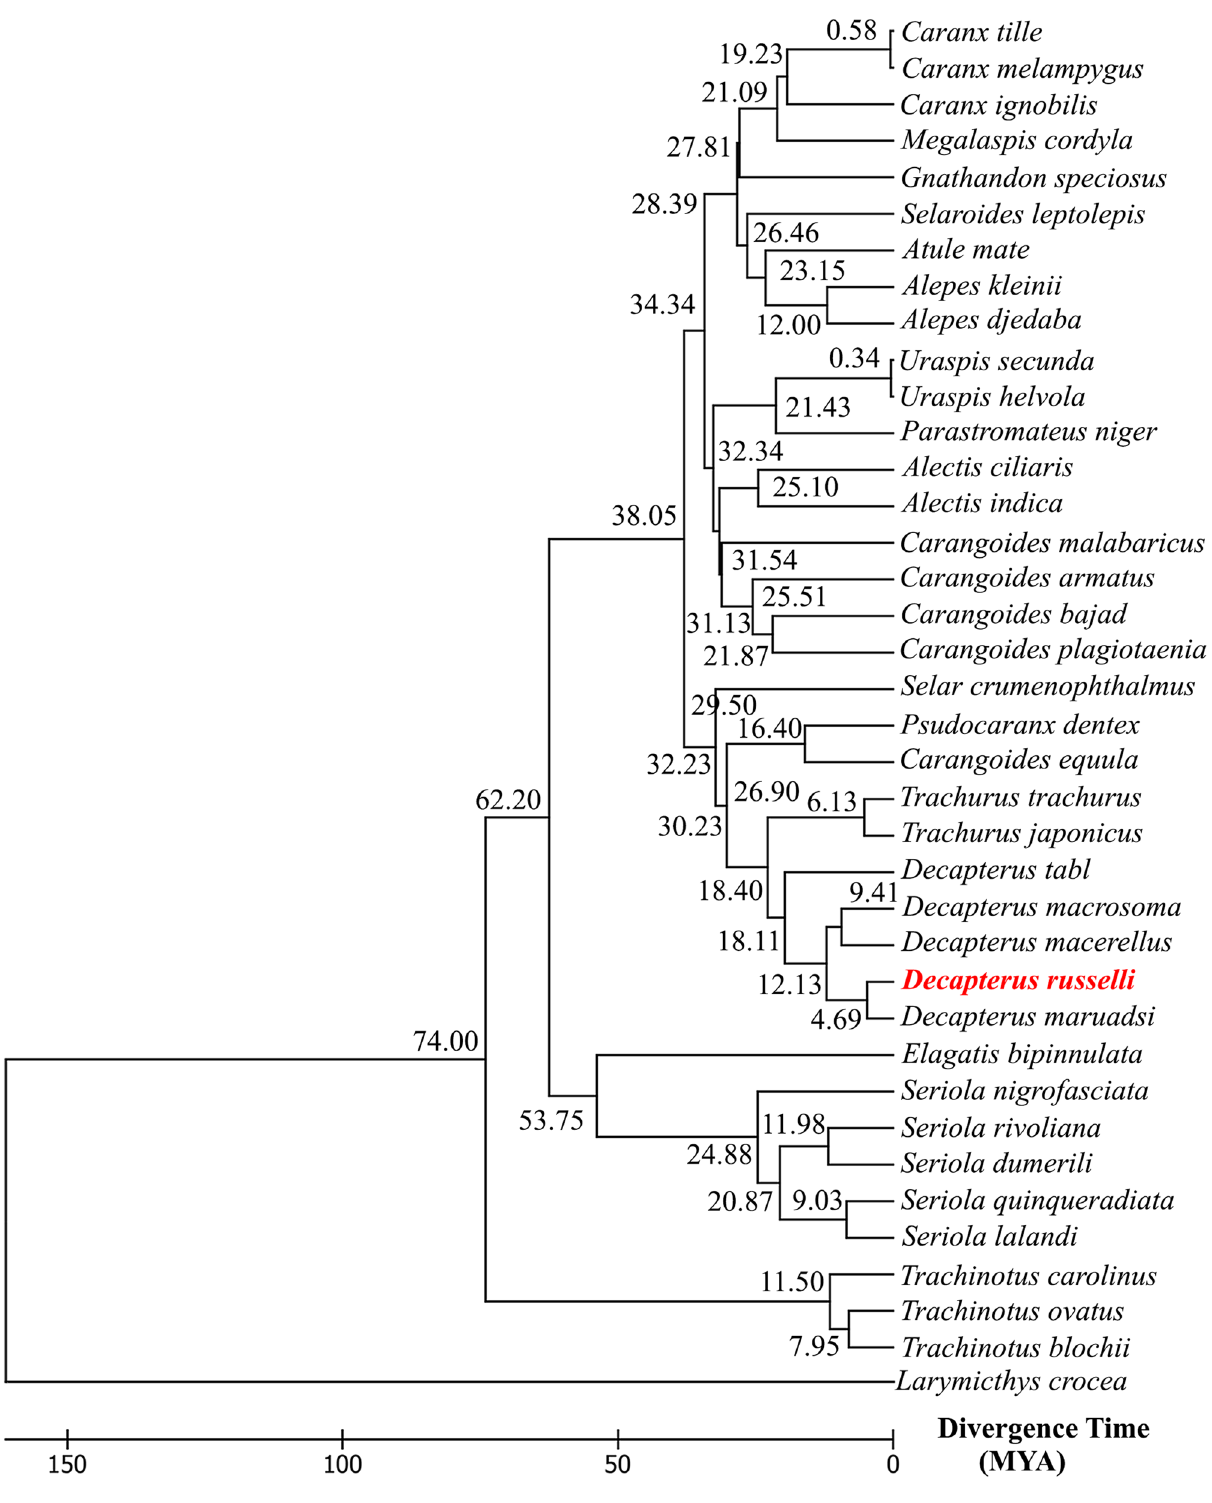
Figure 4. Timetree chronogram of 37 species of Carangidae for the 13 PCGs inferred from Bayesian topology. Divergence times were estimated using 32 calibrations. The red text indicates the species sequenced in this study. The Timetree was generated by using MEGA X 96